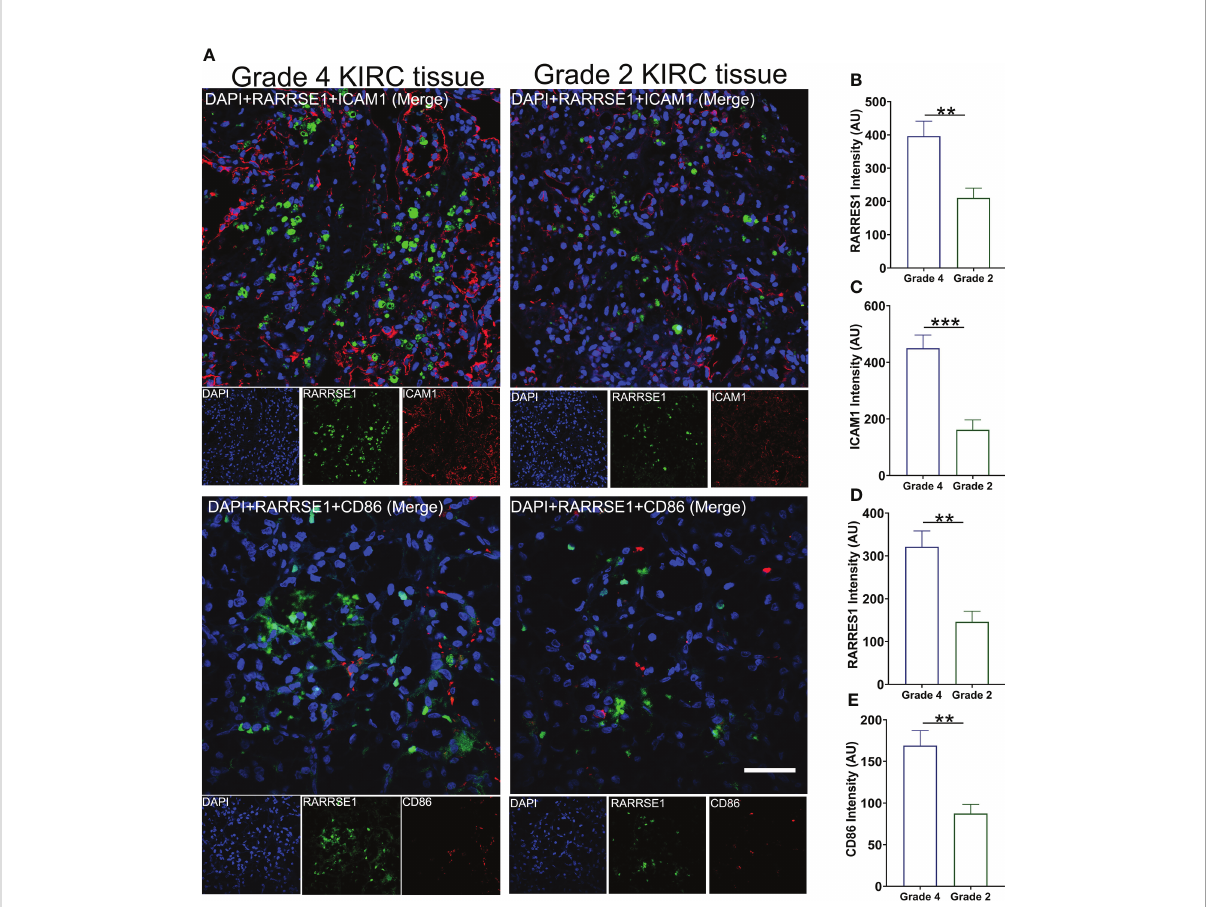
FIGURE 7 Validate the expression of RARRES1, ICAM1 and CD86 in KIRC tumor tissue. (A) The immuno fl uorescence staining of RARRES1, ICAM1 and CD86 in Grade 4 and Grade 2 KIRC samples (Scale bar, 50 m m). Fluorescence intensity of RARRES1 (B) combine with ICAM1 (C) in Grade 4 and 2 KIRC tissue groups. Fluorescence intensity of RARRES1 (D) combine with CD86 (E) in Grade 4 and 2 KIRC tissue groups. n = 3 in each group; **p < 0.01,***p <